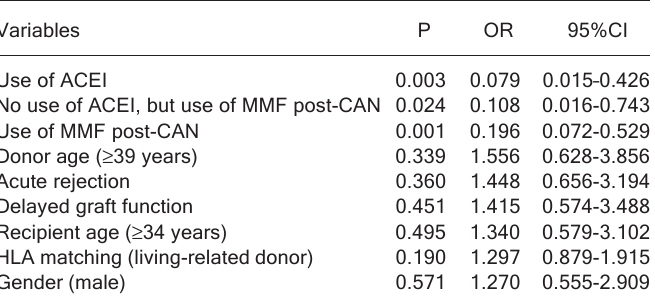
Table 5. COX-adjusted analysis model for graft loss in the population